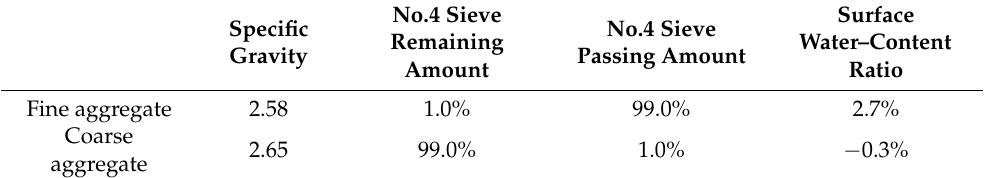
Table 5. Aggregate sieving test